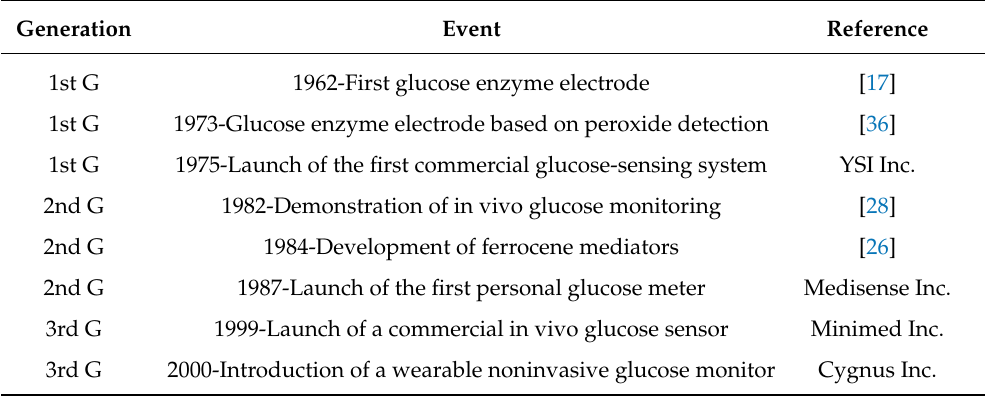
Table 1. Historical landmarks in glucose biosensor development (Reprinted with permission from [35]; published by John Wiley and Sons,